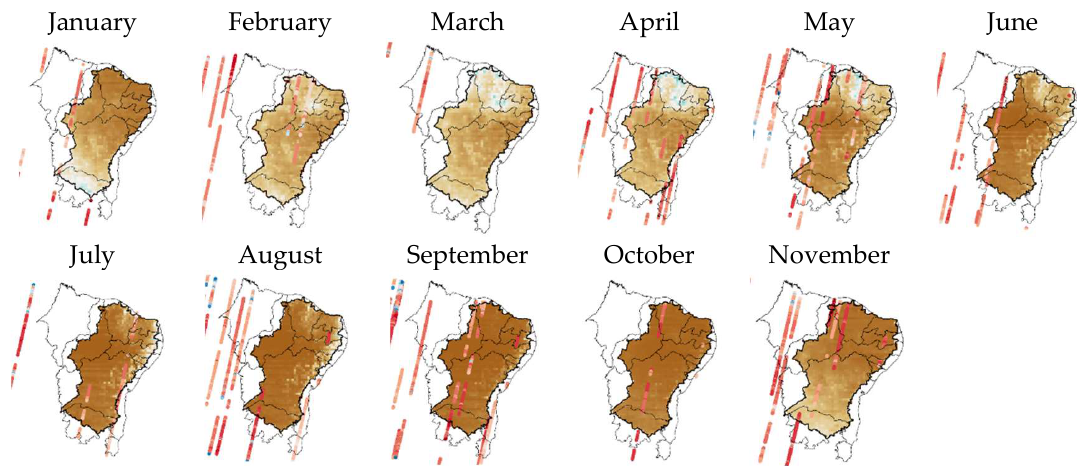
Figure 10. Monthly average spatial-temporal distribution of soil moisture (mm) derived from MUSA model during 2015 year (January to November) and TDS-1 GNSS-R reflectivity (all incidence angles).